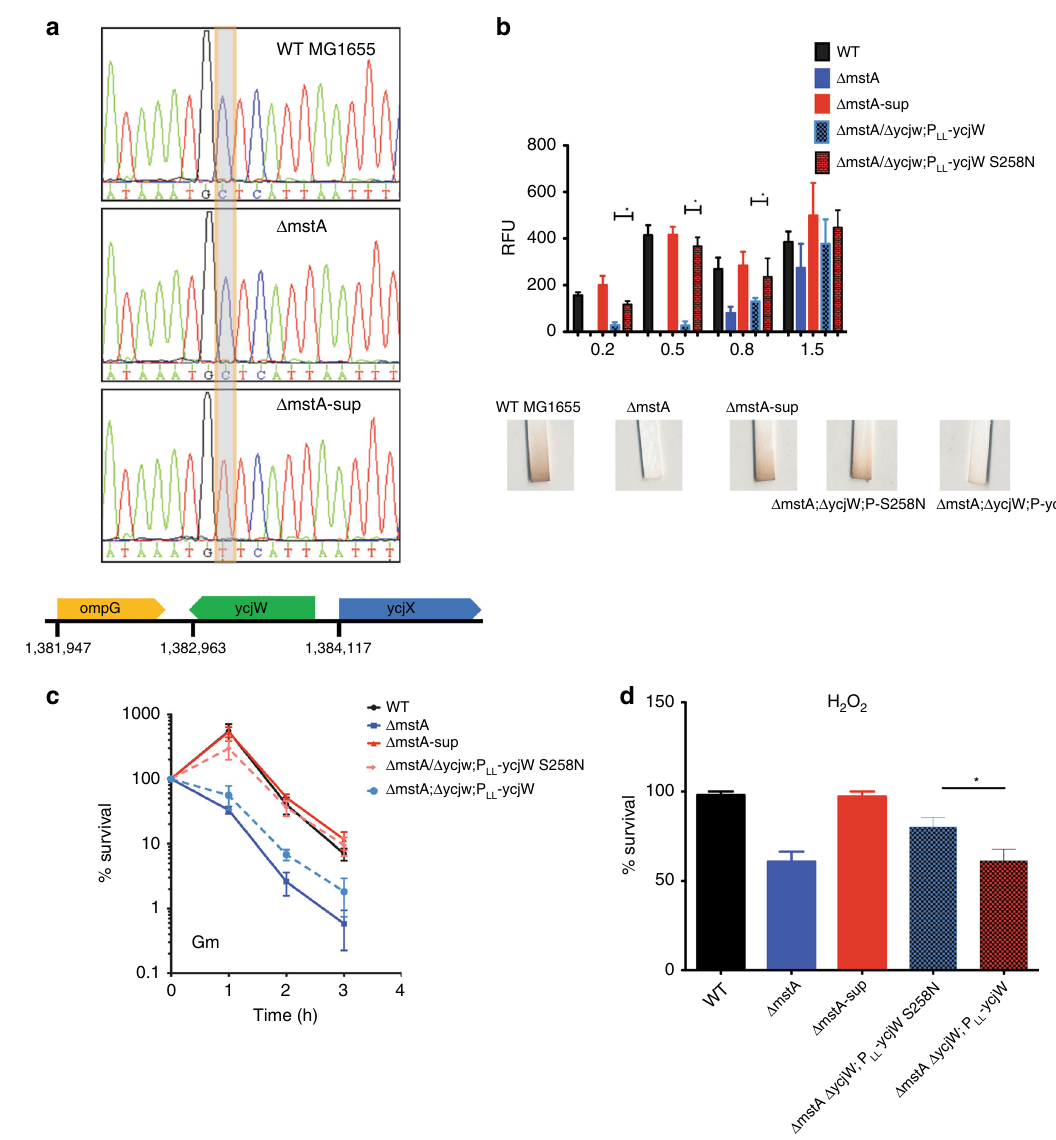
Fig. 2 Unique nonsynonymous SNP in Δ mstA-sup is mapped to the putative transcription factor ycjW . a PCR validation of whole-genome sequencing. Displayed are sequences from E. coli MG155, Δ mstA , and Δ mstA-sup of ( − ) strand. The SNP changes amino acid 258 from serine to asparagine. b Δ mstA / Δ ycW strains with plasmid-expressed P Δ mstA / Δ ycW ; P LL -ycjW or P LL -ycjW S258N were measured for H 2 S production. Only LL -ycjW S258N had increased H 2 S production with no signi fi cant differences with WT or Δ mstA-sup . At OD 600 1.5, no signi fi cant differences exist between strains. c Cells exposed